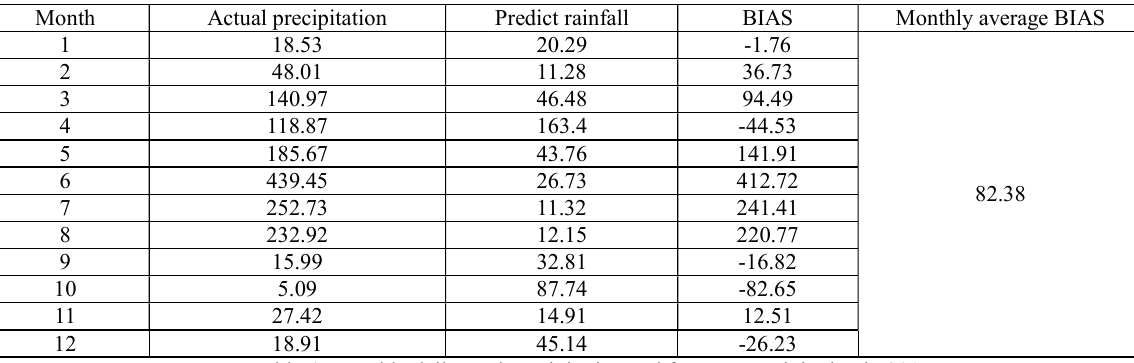
Table 4. Monthly daily total precipitation and forecast precipitation in 2017